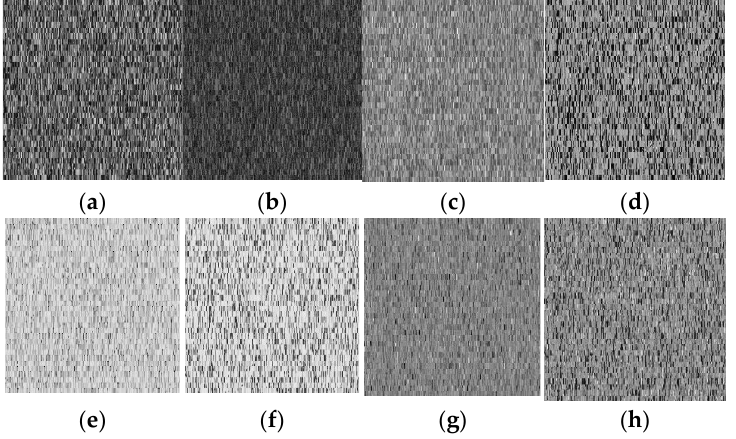
Figure 5. Scrambled images: ( a ) Lena; ( b ) baboon; ( c ) bridge; ( d ) cameraman; ( e ) airplane; ( f ) clock; ( g ) moon; ( h ) ship.